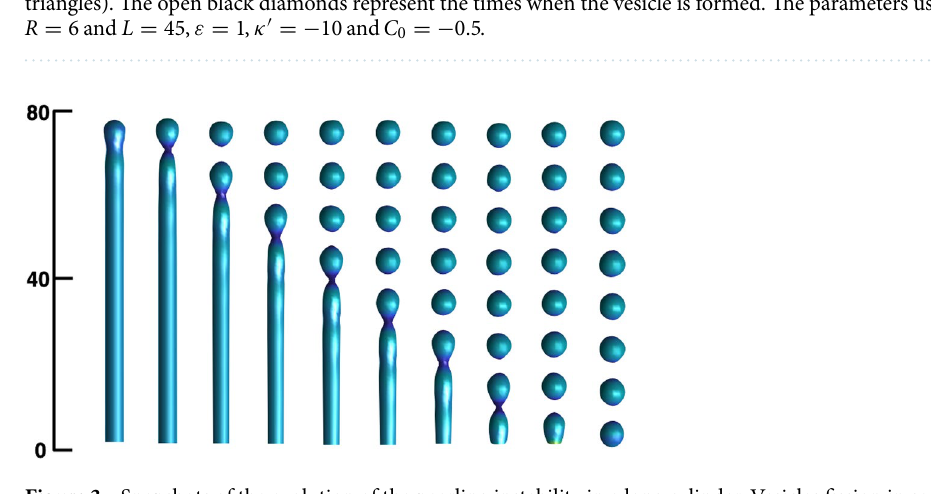
0.5 6 , L 75 , ε 1 , κ 1 , κ 10 and C 0 ′ = − = − = = = =